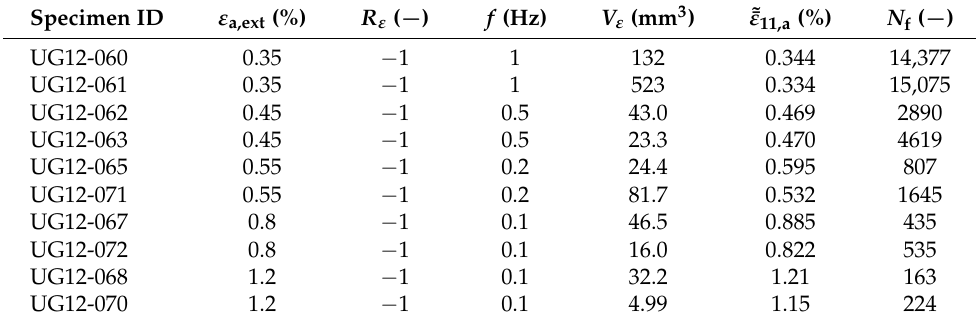
Table 4. Applied extensometer strain amplitude ε a,ext , extensometer strain ratio R ε , test frequency f , highly strained volume V ε , mean effective strain amplitude ˜¯ ε 11,a , and the numbers of cycles to failure N f of the strain-controlled cyclic tests. The tests are performed on the hot-bent